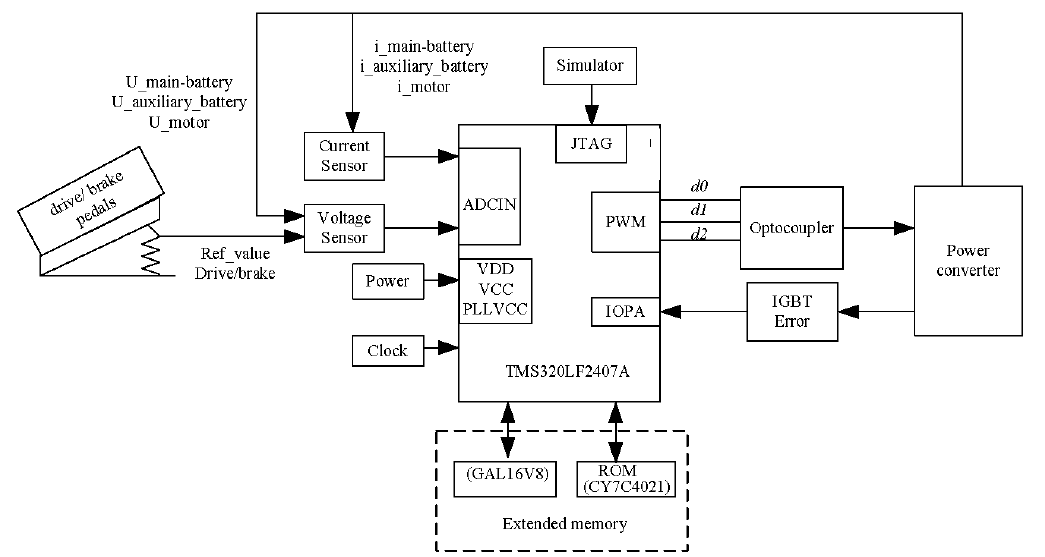
Figure 10. The configuration of the controller